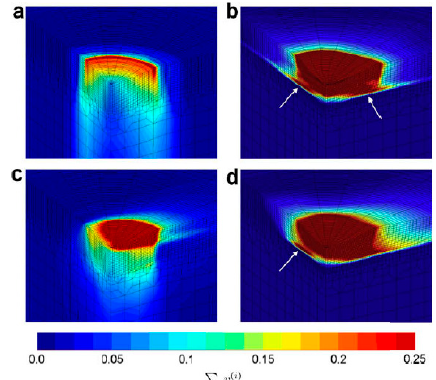
Figure 33. Details of the indentation-induced plastic zone in the simulations concerning hexagonal closest-packed (HCP) zinc crystals. ( a , c ) correspond to the basal and prismatic indented planes of bulk crystals. ( b , d ) correspond to their thin film counterparts. White arrows point to the specific locations where high plastic strain localization occurs within the coating-substrate interface. Penetration depth in the figures is h s = 3.5 µ m [128]. Reproduced with permission from O. Casals et al., Computational Materials Science; published by Elsevier, 2009.